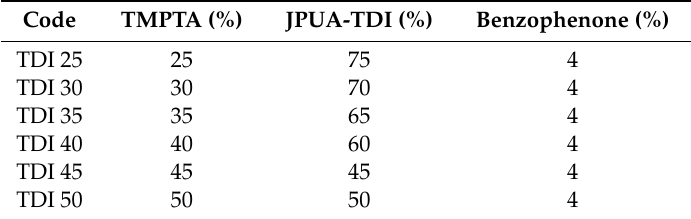
Table 1. Jatropha oil-based polyurethane-toluene diisocyanate (JPUA-TDI)-based coating formulation. Code